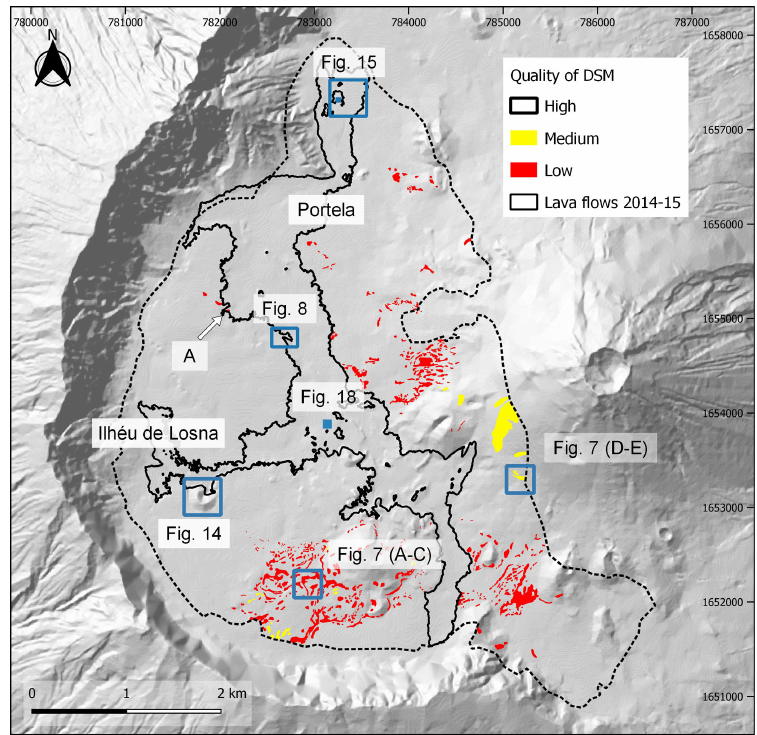
Figure 13. Qualitative assessment of the quality of the digital surface model in the Chã das Caldeiras and location of the sectors shown in different figures. The letter A indicates a small sector of the recent lava flow with low quality. Shaded relief outside the surveyed area derived from the DEMFI (2010) 5m